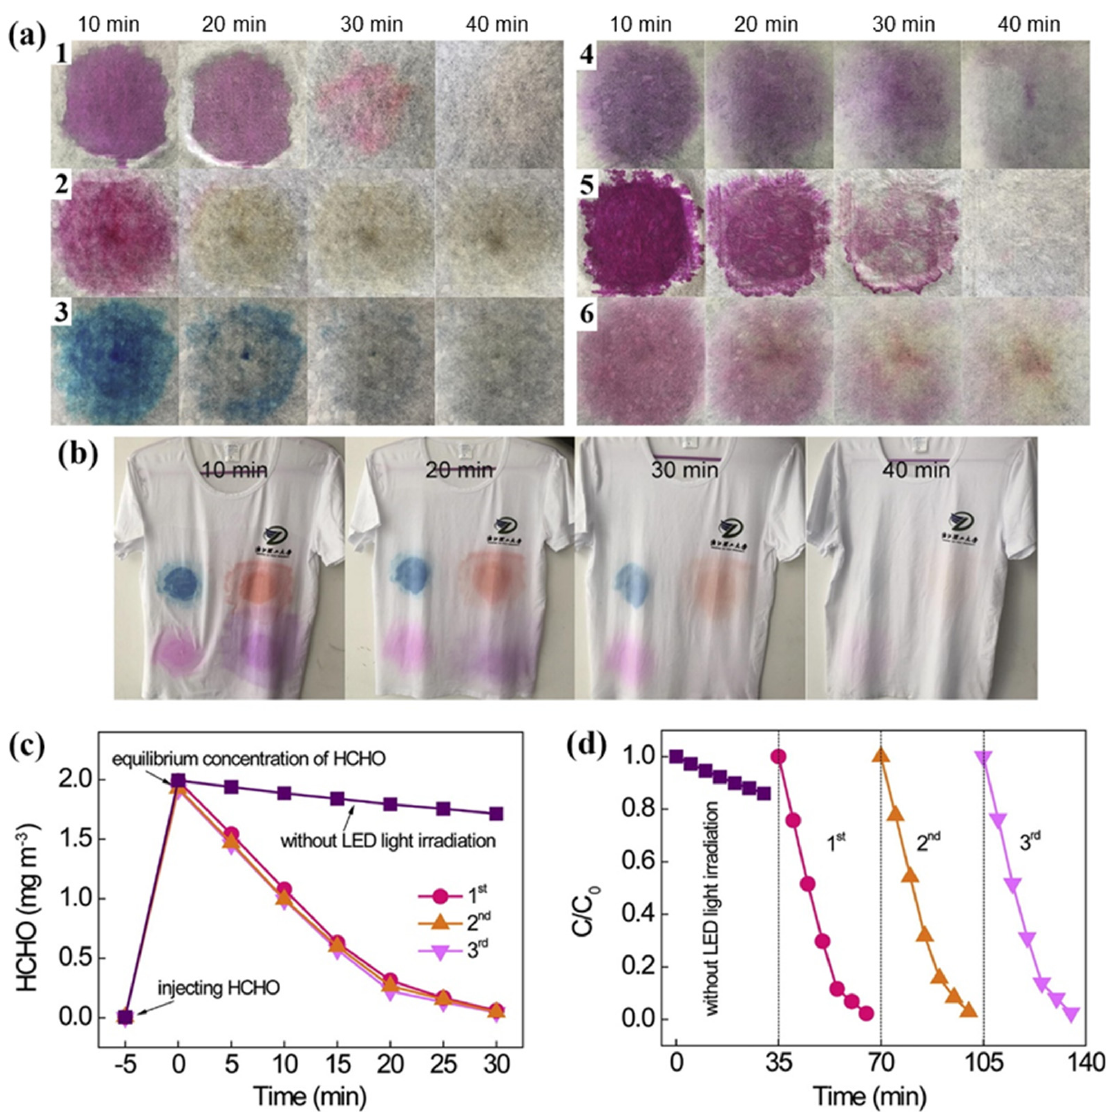
Figure 8. ( a ) The photocatalytic self-cleaning behaviour of g-C 3 N 4 nanosheets modified textiles under sunlight illumination for 40 min: (1) RhB, (2) neutral red, (3) methyl blue, (4) reactive violet, (5) red pitaya juice, (6) waxberry juice; ( b ) the self-cleaning performance of a commercial T-shirt modified with g-C 3 N 4 nanosheets; ( c , d ) the photocatalytic degradation of gaseous formaldehyde by a g-C 3 N 4 nanosheet modified textile under irradiation with a LED lamp (50 W). Reprinted with permission from [44]. Copyright 2019, Elsevier.